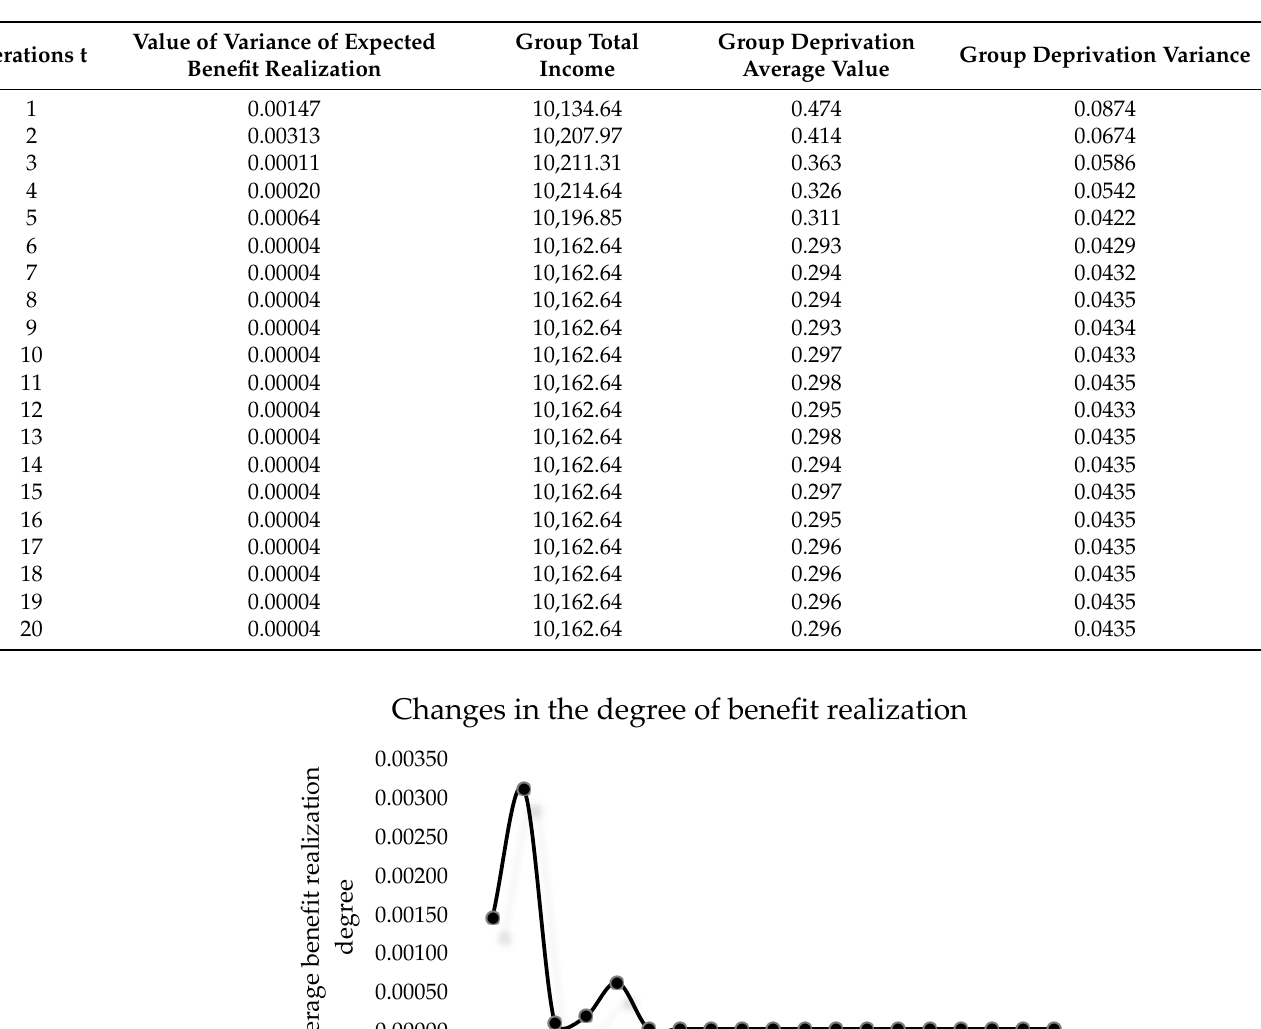
Table 4. Updates of relevant indicators.